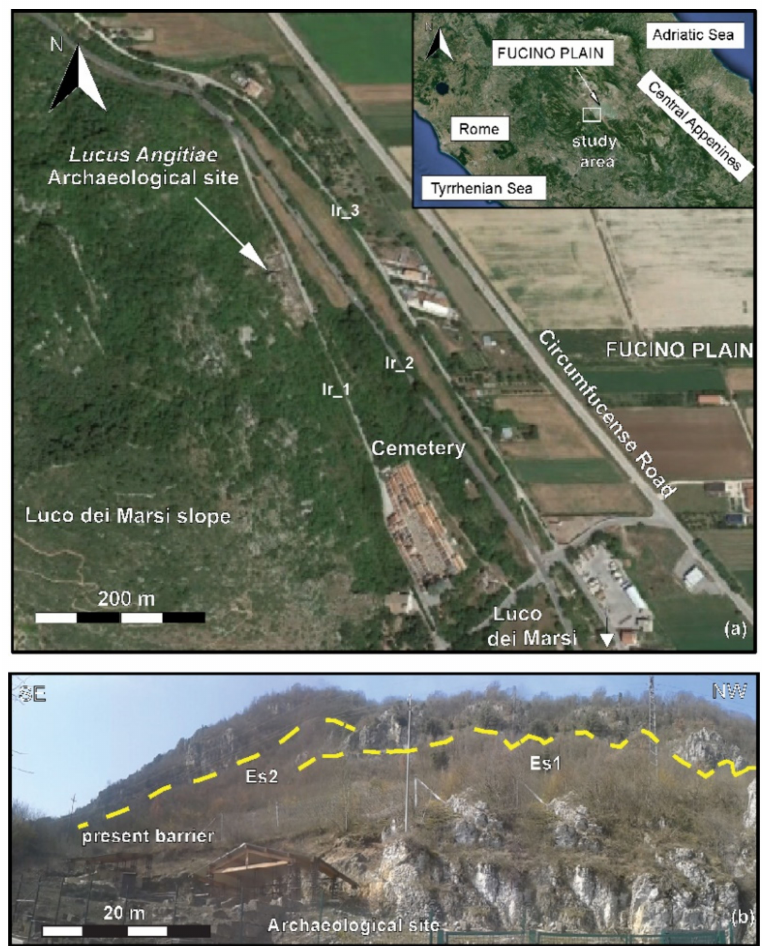
Figure 1. ( a ) Aerial view of the study area along the western border of the Fucino Basin in central Italy (see the upper right insight). The position of the Lucus Angitiae archaeological site and the local road network (Circumfucense Road and lr_1-3) is also reported; ( b ) rock slope escarpments Es1 and Es2 impending on the archaeological site. It is worth noting the presence of elastic barriers which partially protect the